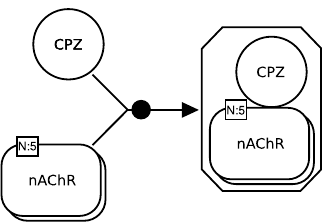
Figure 2.35: Association of cyclin and CDC2 kinase into the Maturation Promoting Factor.